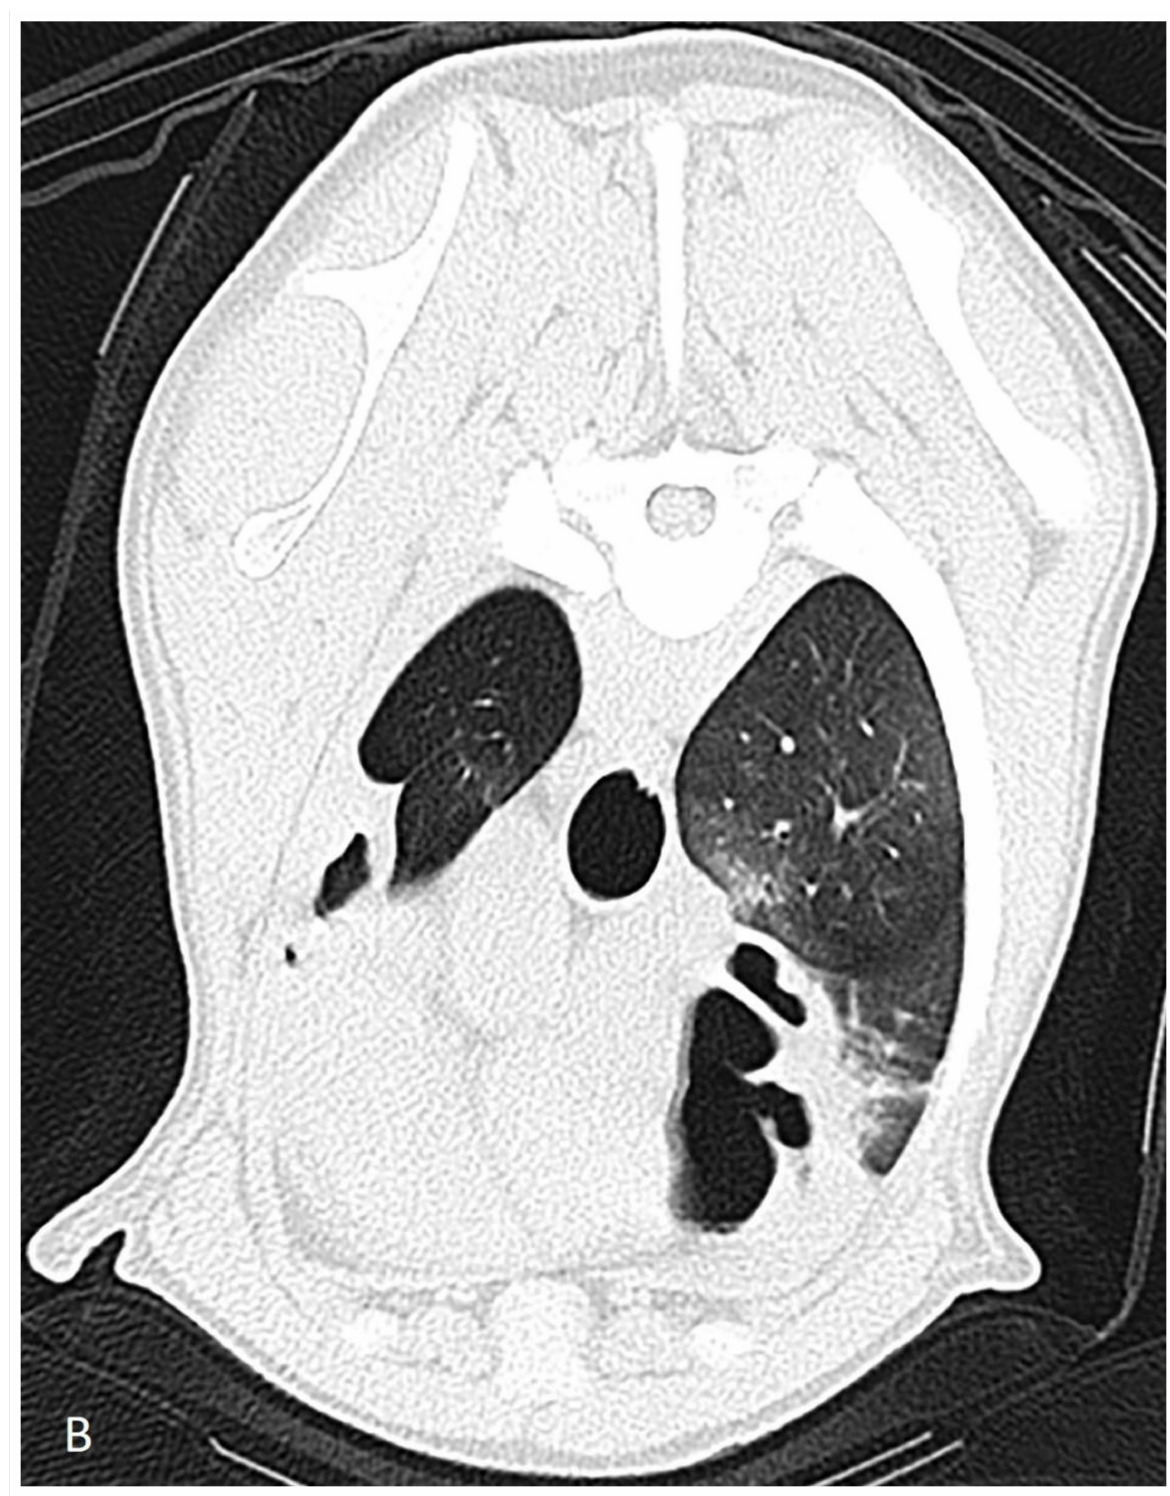
Figure 1. Computed tomographic scan of a 9-month-old German shepherd dog with multifocal bronchiectasis of unknown origin. Left of the animal is on the left side of the image. ( A ) Severe dilation of the lobal bronchus in the center of the left caudal lung lobe can be appreciated. The right caudal lung lobe has a larger volume compared to that of the left one and has normal tapering bronchi to the periphery. ( B ) Severe saccular dilation and lack of tapering to the periphery of the lobal bronchus of the right cranial lung lobe can be